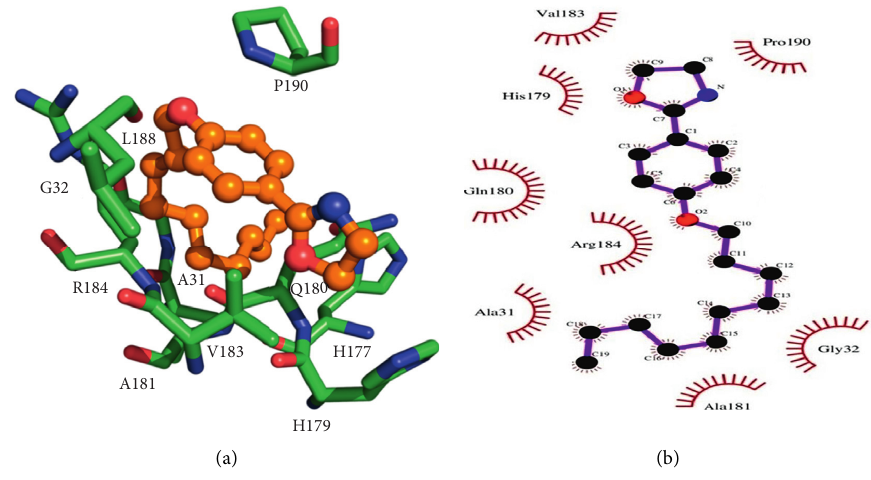
Figure 15: The interaction of 18 with CviR shown in 3D.